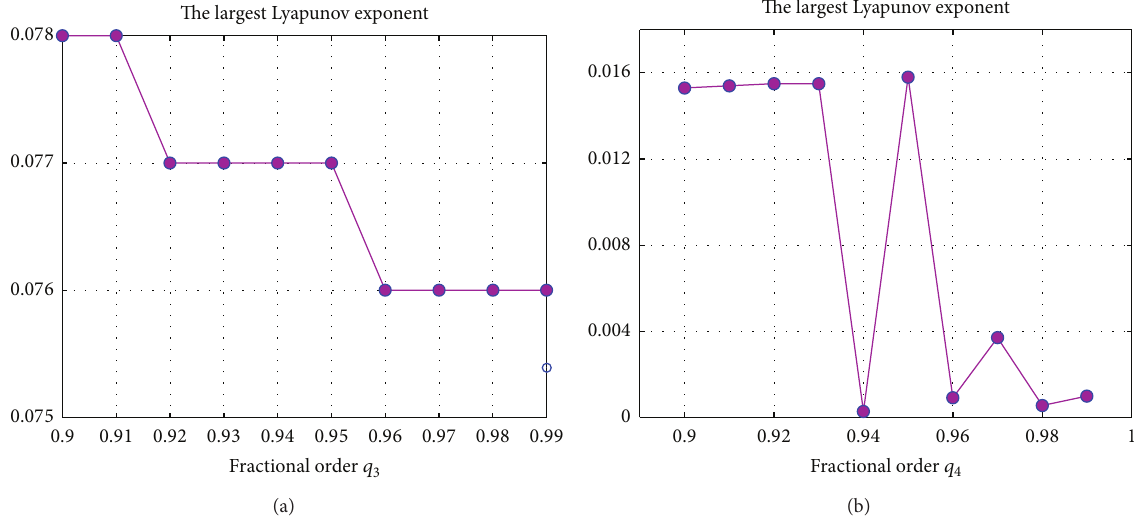
Figure 6: The Largest Lyapunov Exponent of the fractional-order power system; (a) 𝑞 2 = 𝑞 1 = 𝑞 4 = 1 , 𝑞 3 = 0.99 , and (b) 𝑞 2 = 𝑞 3 = 𝑞 1 = 1 , = 0.99 𝑞 4